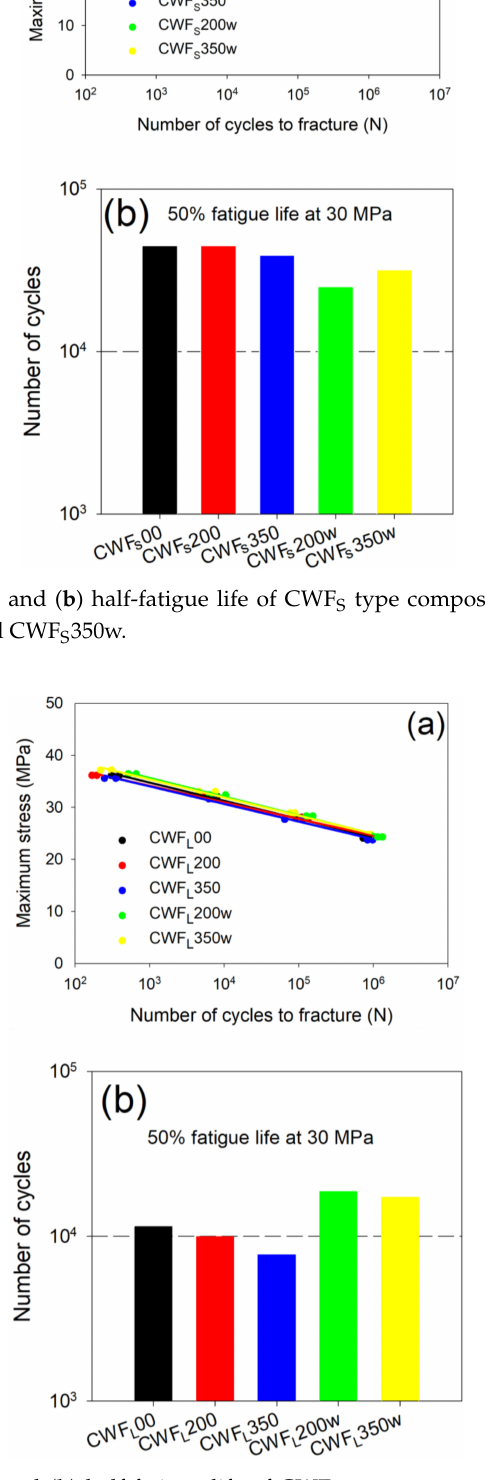
Figure 7. ( a ) S–N curves and ( b ) half-fatigue life of CWF L type composites: CWF L 00, CWF L 200, CWF L 350, CWF L 200w, and CWF L